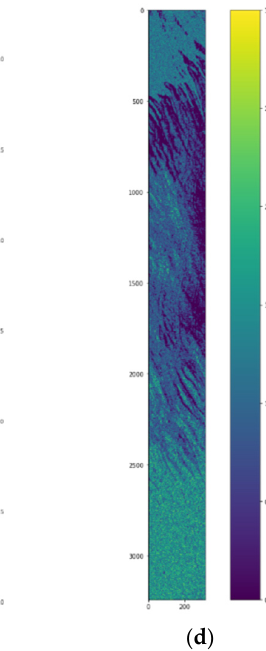
Table 5. The classification accuracy for CyanoHAB HSI using PCA 3, 5, and 7 bands, with the three types of scaling using the four machines for a 1000 pixels batch size.